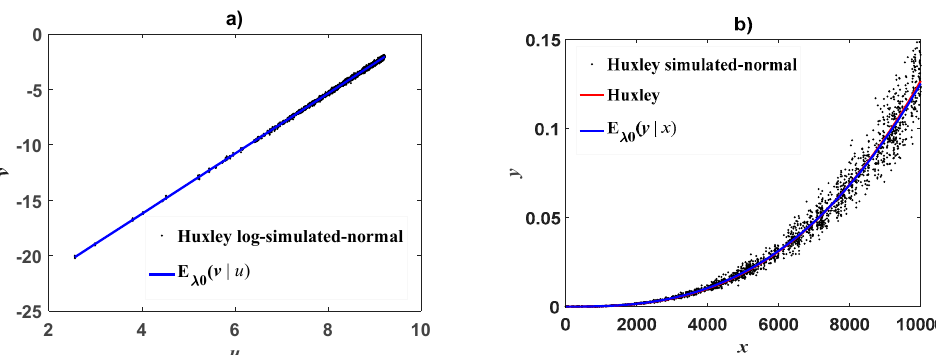
Figure E2. Panel ( a ) displays spread of 𝑣 (cid:3038)((cid:3036)) (𝜖) replicates about the mean response line 𝜆 (cid:2868) (𝑢) = 𝑝 (cid:2868) + 𝑞 (cid:2868) 𝑢. Panel ( b ) comparison of retransformed mean response 𝐸 (cid:3090)(cid:2868) (𝑦|𝑥) and fitted power function 𝑦 = 𝛽𝑥 (cid:3080) resulting from a DNLR fit on simulated data (𝑥 (cid:3036) ,𝑦 (cid:3038)((cid:3036)) (𝜖)) . Panel ( a ) reveals no curvature effects induced by a log transformation. Panel ( b ) suggest reliable agreement between observed and retransforming mean response 𝐸 (cid:3090)(cid:2868) (𝑦|𝑥) No biased results can be attributed to using a logtransformation procedure.